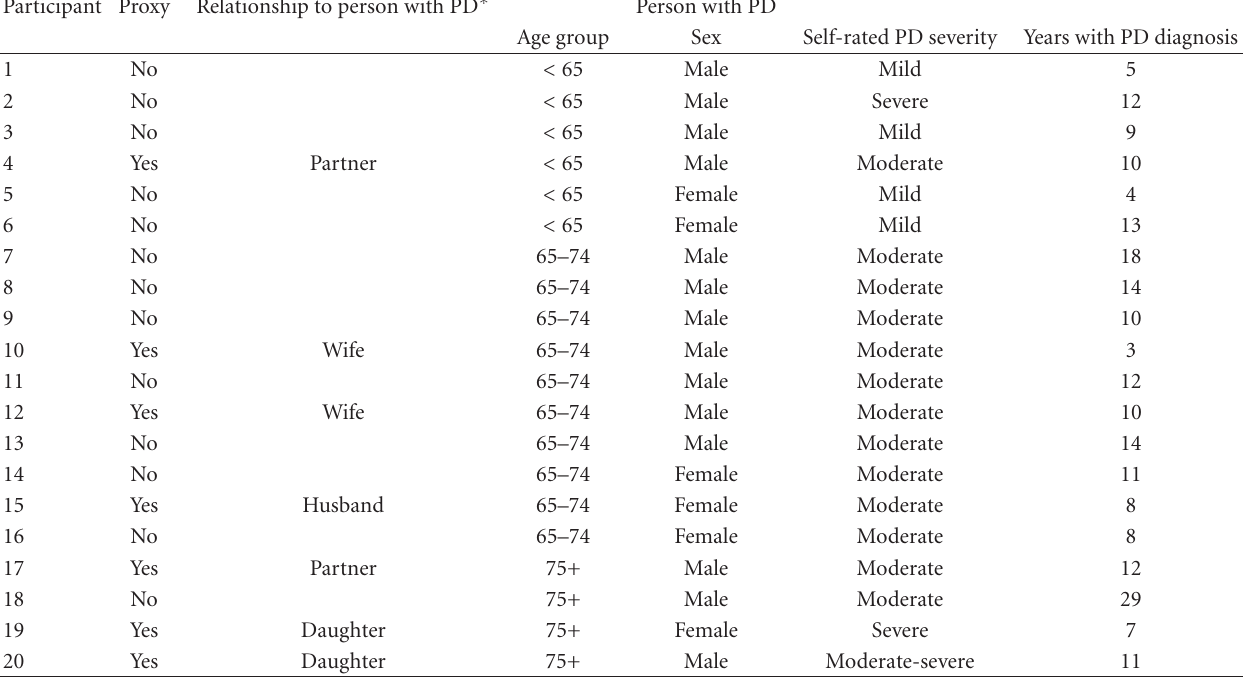
Table 1: Participant